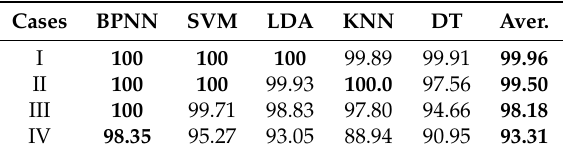
Table 2. Classification results of four cases on all data-sets (Back-Propagation Neural Network (BPNN), Support Vector Machine (SVM), Linear Discriminant Analysis (LDA), K-nearest neighbour (KNN), Decision Tree (DT), average value (Aver.)).